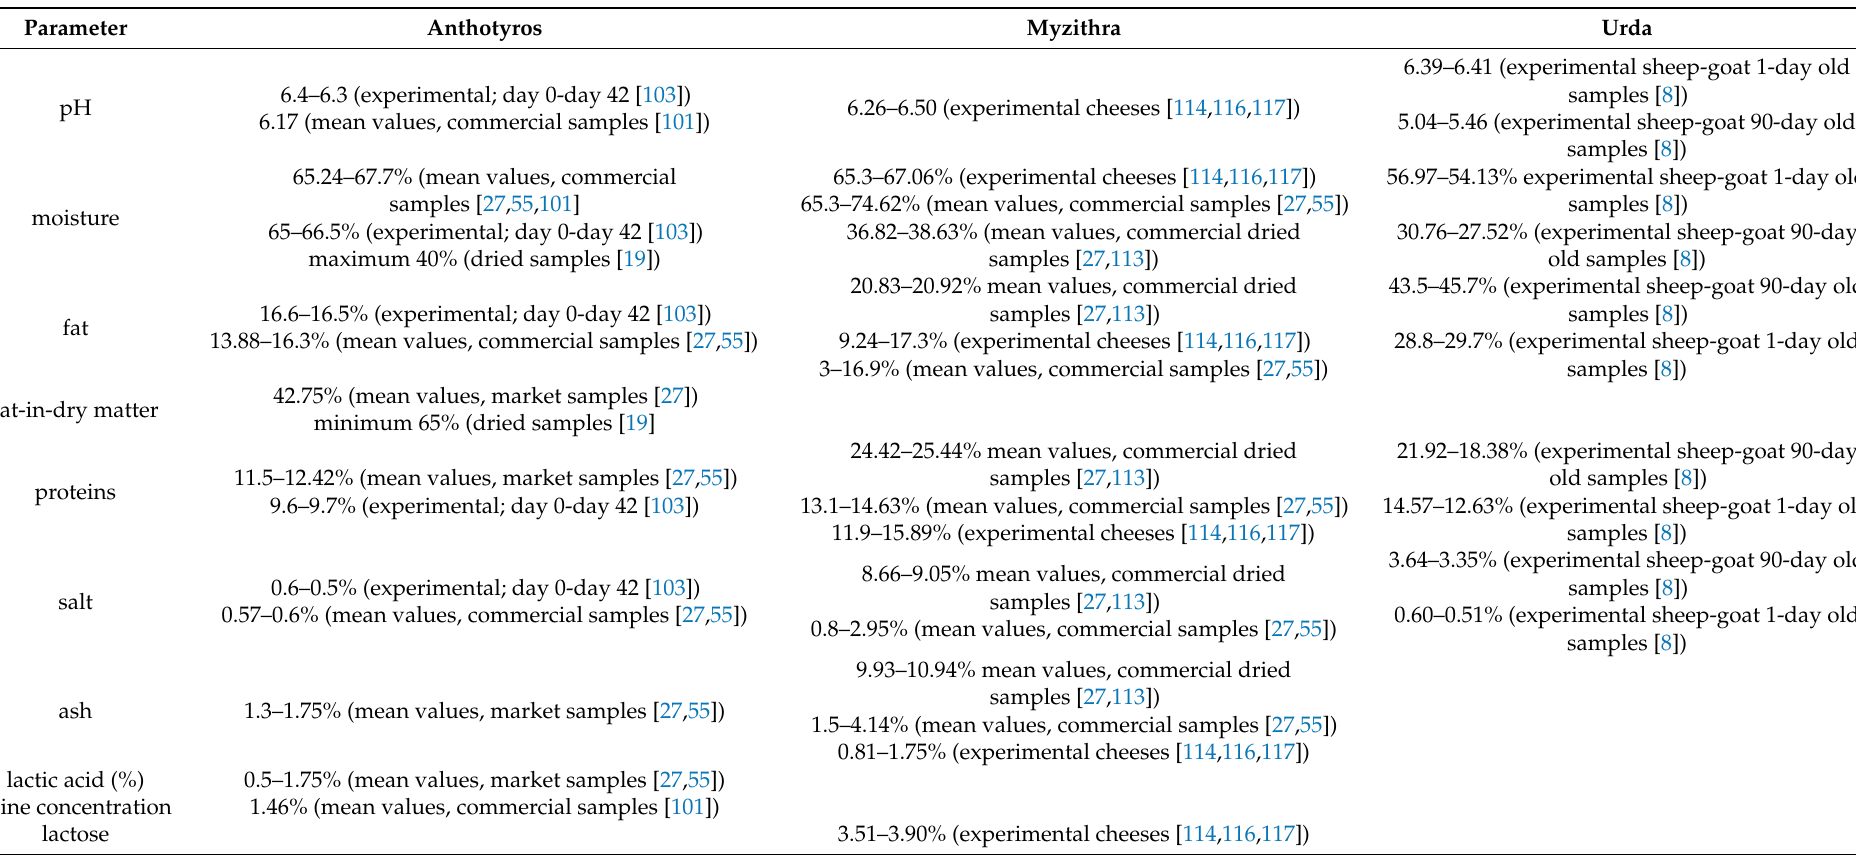
Table 12. Composition of nonprotected designation of origin and nonprotected geographical indication whey